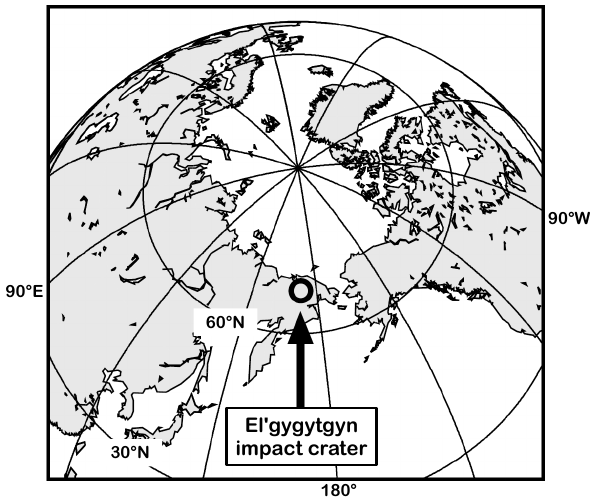
Fig. 1. Location of Lake El’gygytgyn in the Far Eastern Russian Arctic. The circle (not to scale) marks the site of the impact